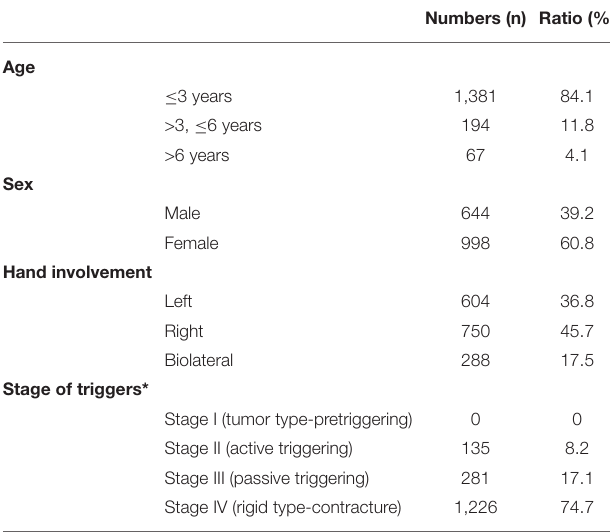
TABLE 1 | Demographics of the pediatric